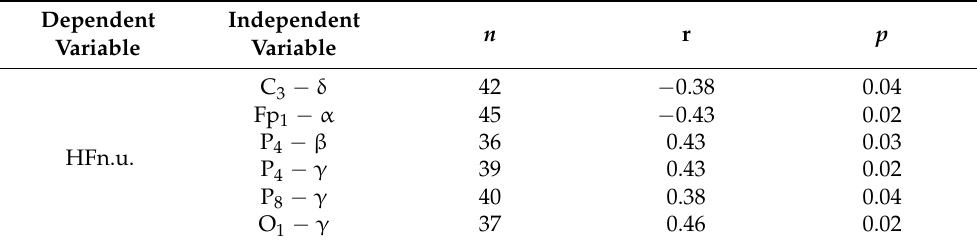
Table 7. Significant associations between electroencephalography variables and normalised high frequency heart rate variability of train drivers.